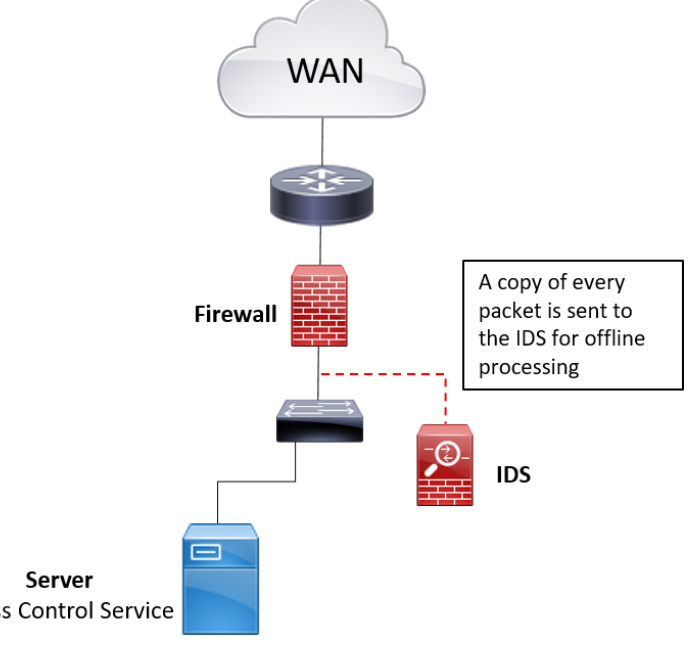
Figure 1. Diagram of a simple network connected to a Wide Area Network (WAN) with a firewall and an intrusion detection system